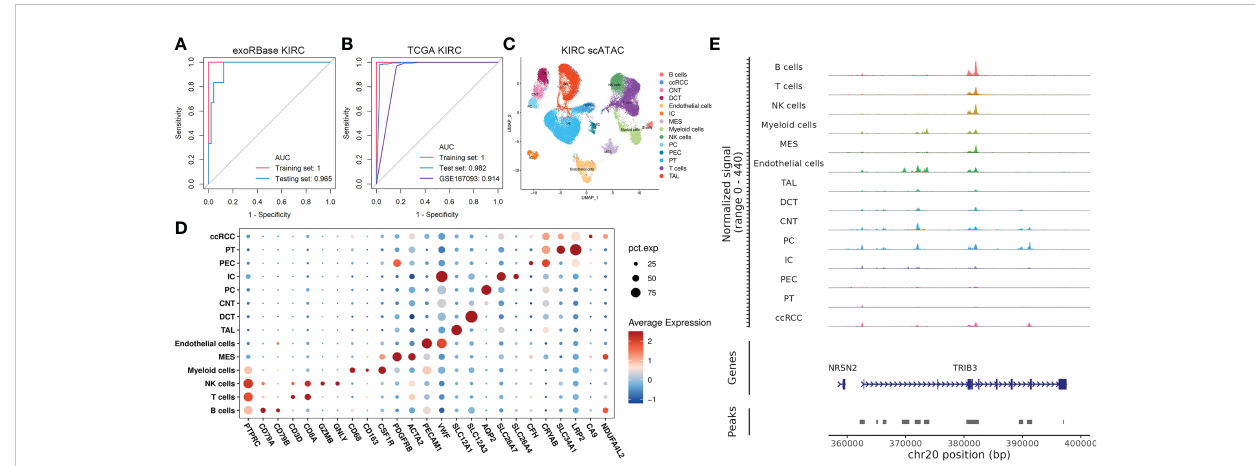
FIGURE 5 Construction of 13-gene diagnostic models and single-cell assays for transposase-accessible chromatin (scATAC-seq) analysis. (A) Receiver- operating characteristic (ROC) curve analysis of a 13-gene diagnostic model based on exoRBase kidney renal clear cell carcinoma (KIRC) cohort, with the red curve representing the training set and the blue curve representing the testing set. (B) ROC curve analysis of a 13-gene diagnostic model based on The Cancer Genome Atlas KIRC combined with GTEx cohort and KIRC cohort from the GEO database with accession number GSE167093, with the former treated as the training set (red) and the testing set (blue). In contrast, the latter was an additional validation cohort (purple). (C) Uniform manifold approximation and projection plot showing the 14 cell clusters in the scATAC-seq analysis (D) Bubble plots showing the marker genes for each cell cluster in scATAC-seq. (E) CoveragePlot showing the peak – gene links for